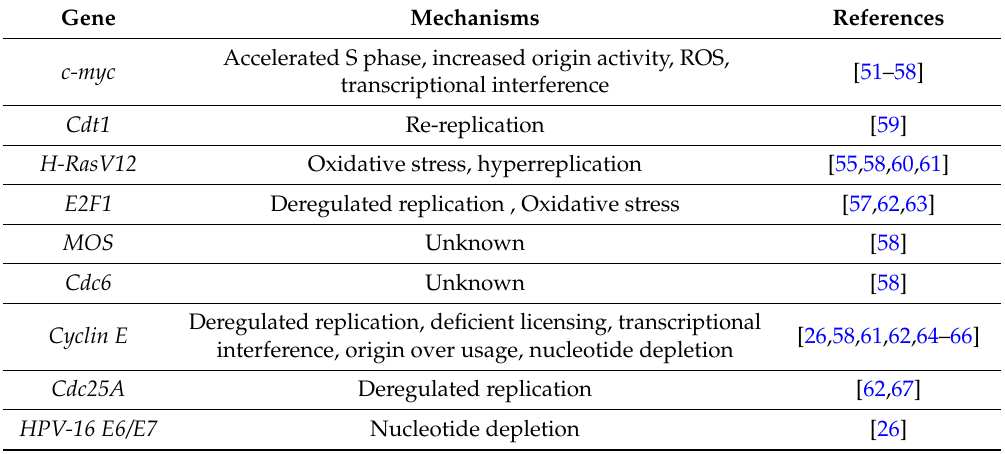
Table 1. Oncogenes involved in replication